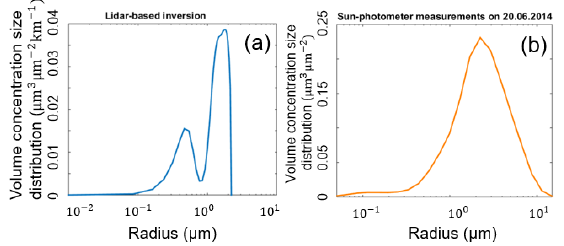
Figure 4. Retrieved lidar-reduced VCSD for 1.5- 2.75 km (left) and AERONET VCSD (right).